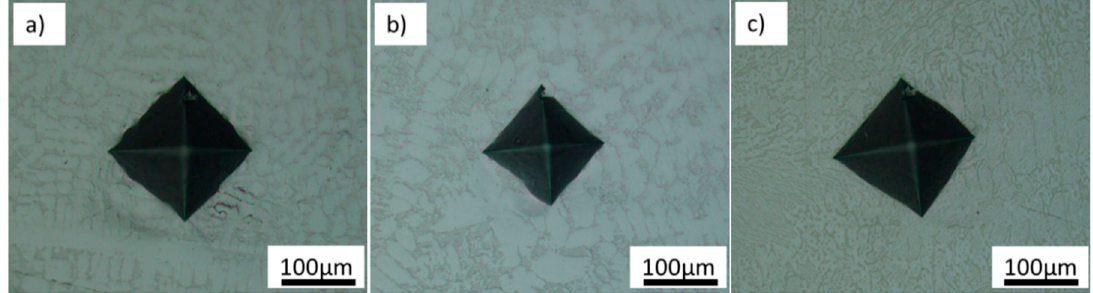
Figure 9. The hardness indentation images of Al 0.6 : ( a ) as-cast, ( b ) heat-treated at T = 800 °C and ( c ) heat-treated at T = 1000 °C. Table 2. Properties of Al 0.6 high-entropy alloys.